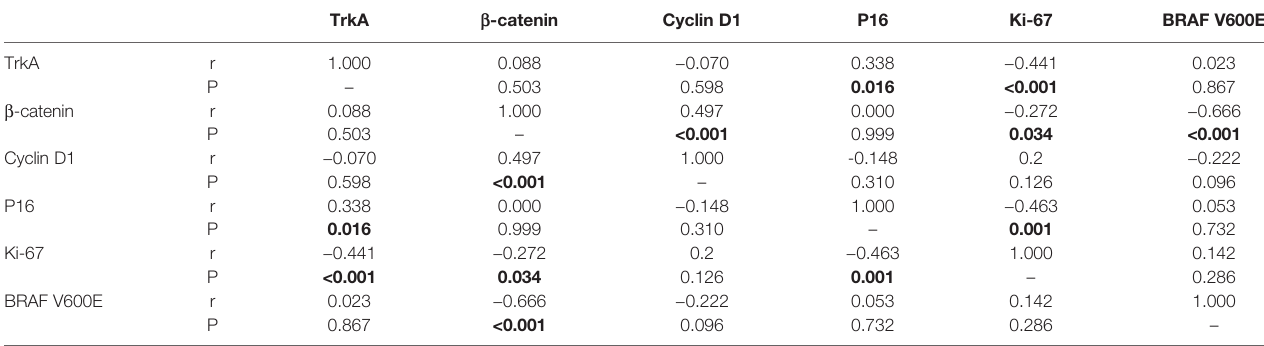
The statistically signi fi cant fi nding was highlighted with bold.